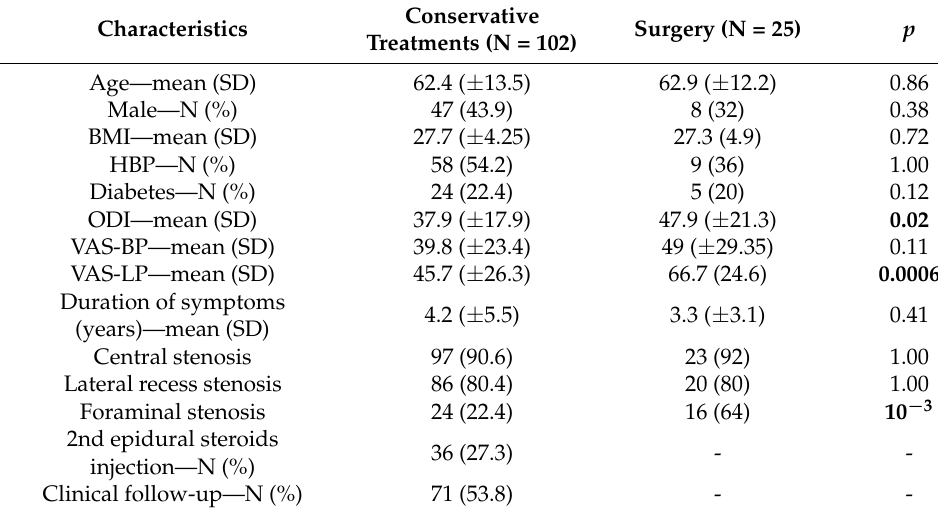
Table 1. Population characteristics at baseline.